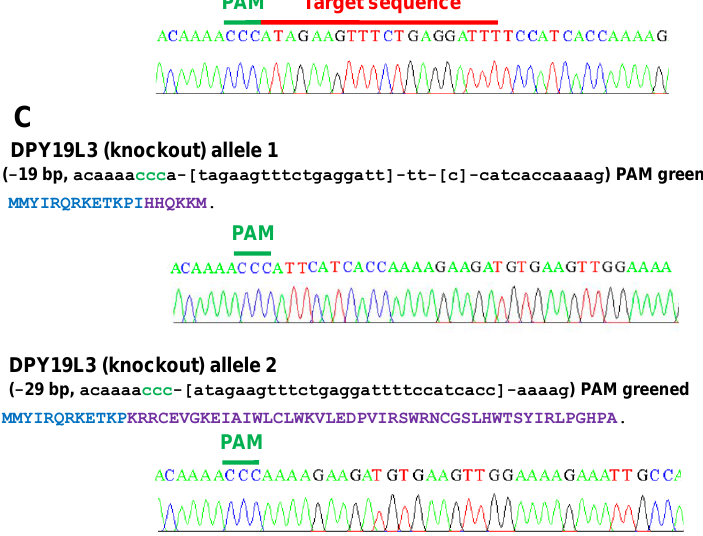
Figure 2. Establishment of DPY19L3-knockout C2C12 cells. ( A ) Target sequences of sgRNAs to establish DPY19L3-KO cells by using the CRISPR/Cas9 system. The sequence is in part of exon 1 of mouse DPY19L3. The target sequences of sgRNAs and the PAM sequences are colored in red and green, respectively. ( B ) The amino acid sequence of wild-type mouse DPY19L3. (Upper) Amino acids encoded in exon 1 and targeted region are colored in blue and red, respectively. (Lower) The nucleic acid sequence of wild-type mouse DPY19L3. ( C ) Expected DPY19L3 protein sequences in C2C12-DPY19L3-KO cells. Purple characters are artificially generated amino acids by CRISPR/Cas9- mediated frameshift